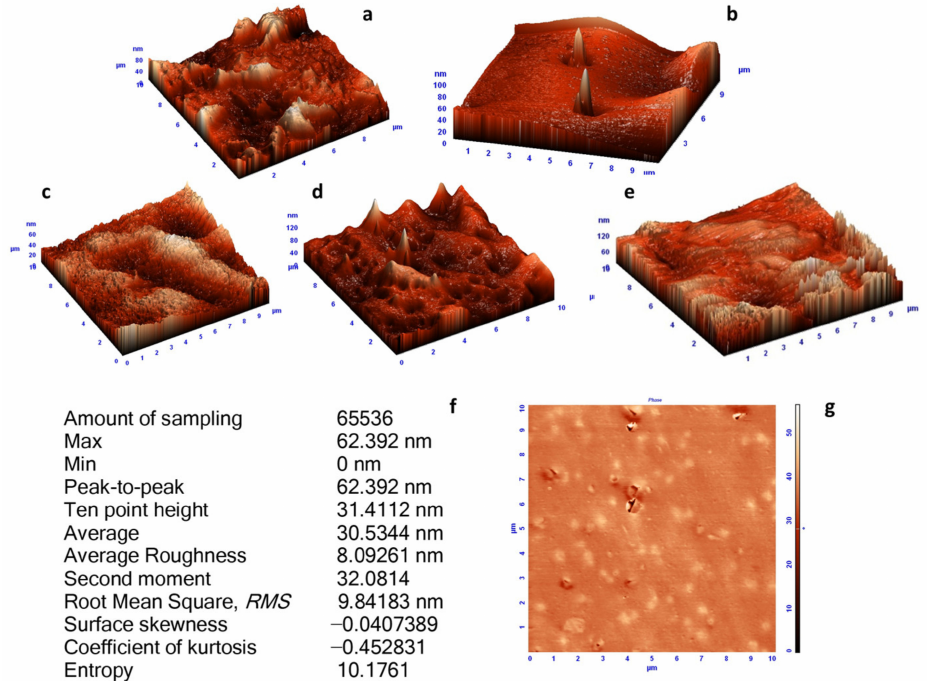
Figure 4. AFM scans of the reference samples (A–( a ), C–( b )) and AxCy series (A1C1–( c ), A1C2–( d ), A2C1–( e )) and phase contrast for sample A1C1–( g ), with statistical parameters of roughness-( f